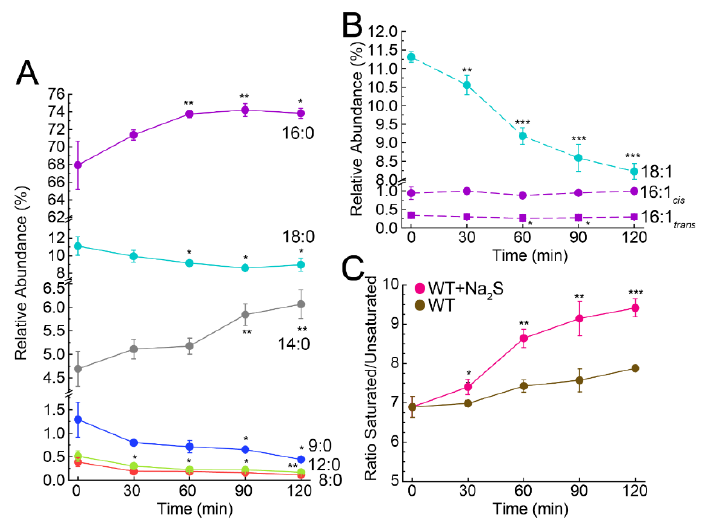
Figure 3. Fatty acid profiling in WT E. faecalis . Changes in the relative abundance for ( A ) saturated and ( B ) unsaturated fatty acids after the addition of exogenous Na 2 S to cell cultures. ( C ) The ratio of total saturated to unsaturated fatty acids for Na 2 S treated cells vs. untreated wild-type cells. Values represent the means ± S.D. derived from the results of biological triplicate experiments, with statistical significance established using a paired t-test relative to the endogenous, time 0 (*** p ≤ 0.001, ** p ≤ 0.01, * p ≤ 0.05).